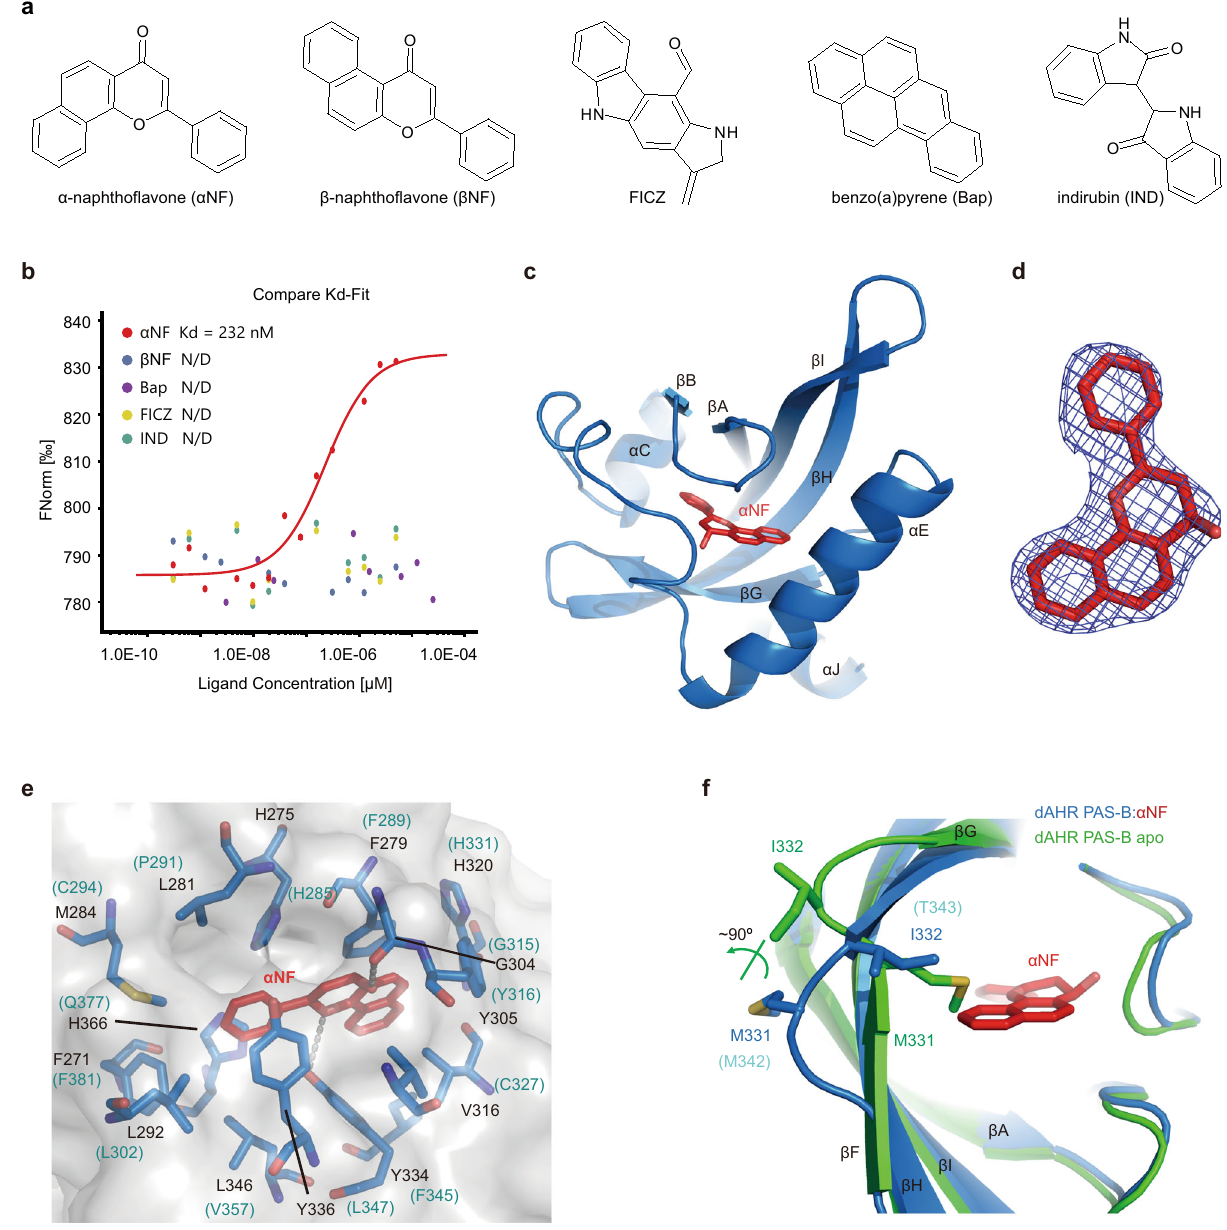
Fig. 2 | The binding of α NF to dAHR PAS-B. a Chemical structure of typical AHR ligands. b Binding of different AHR ligands to dAHR PAS-B detected by MST. Data are presented as mean values of two independent experiments. Source data are providedasaSourceData fi le. c Structureof α NF(redsticks)incomplexwithdAHR PAS-B. d The 2Fo-Fc omit map of α NF. The map is shown in gray mesh and con- toured at 1.0 σ . e The binding of α NF in the dAHR PAS-B internal cavity. Residues